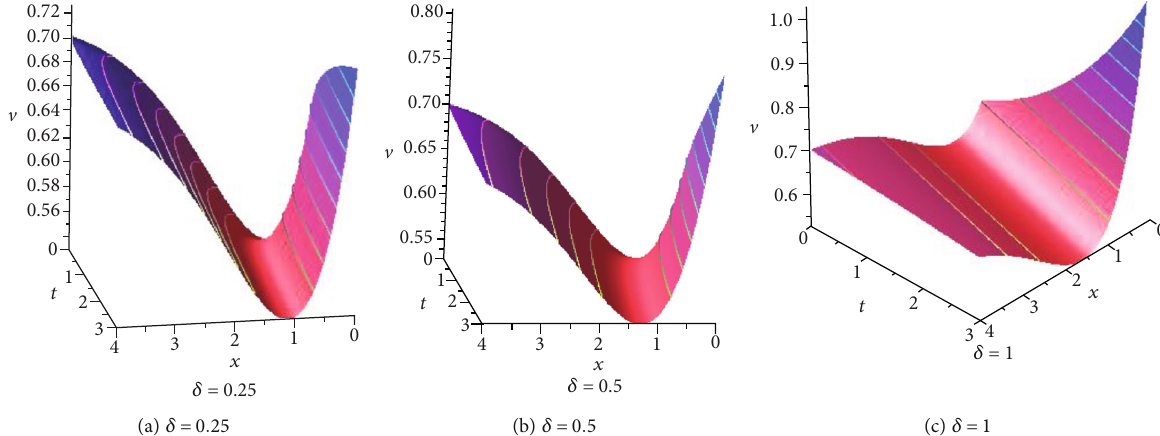
Figure 12: Dark bell wave for a = h = 1 of (53): (a, b) curvy surface for fractional order, (c) straight surface for complete order of